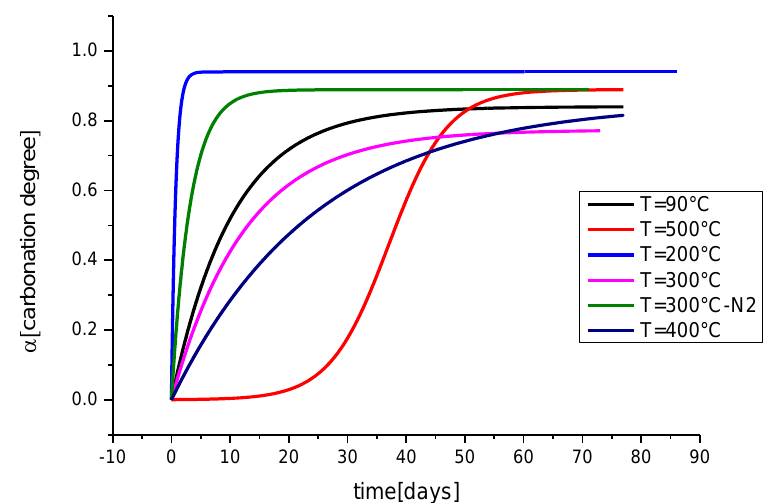
Figure 6. Kinetic model applied to experimental data using Equation (6). Samples of calcium hydroxide were treated at different temperature ranging from 90 °C to 400 °C.